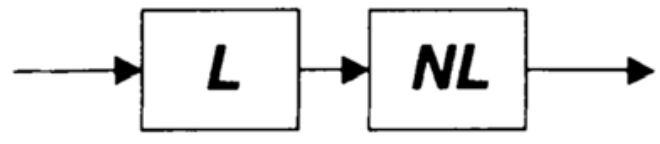
Figure 12. Block diagram of Wiener